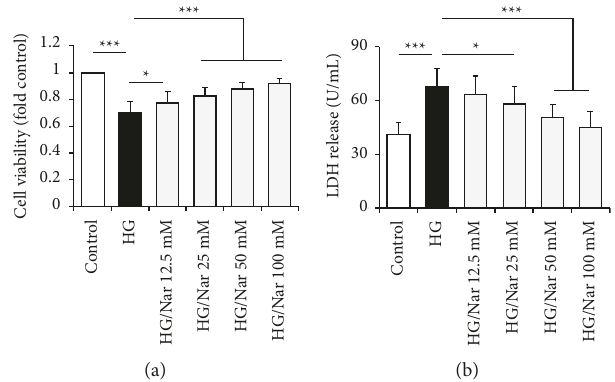
Figure 1: Effect of Nar on HG-induced cell damage. HUVECs were exposed to NG (5.5mM glucose) or HG (30mM glucose) media with or without the indicated concentration of Nar for 72h. (a) Effect of Nar on cell viability. (b) Effect of Nar on LDH concentration in the culture media. Data are expressed as means ± SD ( n � 4). ∗ P < 0 . 05 and ∗∗∗ P < 0 . 001 versus the indicated group.